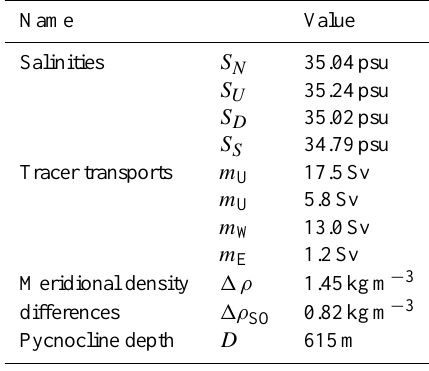
Table 2. Numerical solution of the model by applying the finite dif- ference method on Eqs. (1)–(6). Equilibrium state is obtained after 2000 years with a time step of 14 days and the starting